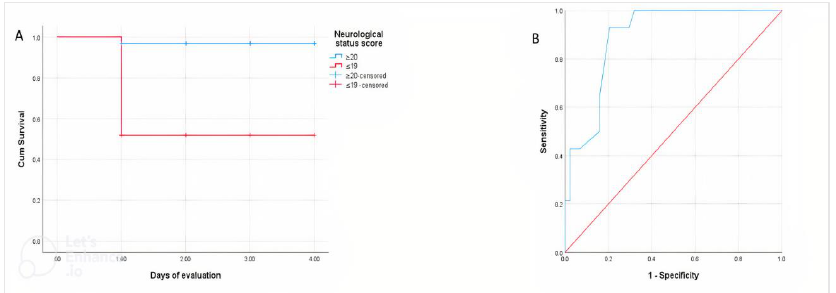
Figure 1. Kaplan-Meier analysis with log-rank test showed that the survival period was significantly shorter in calves with perinatal asphyxia with a neurological status score ≤19 ( A ). Receiver operating characteristic curve (ROC) analysis for the differentiation between the survivor and non-survivor calves with asphyxia based on neurological status score ( B ).